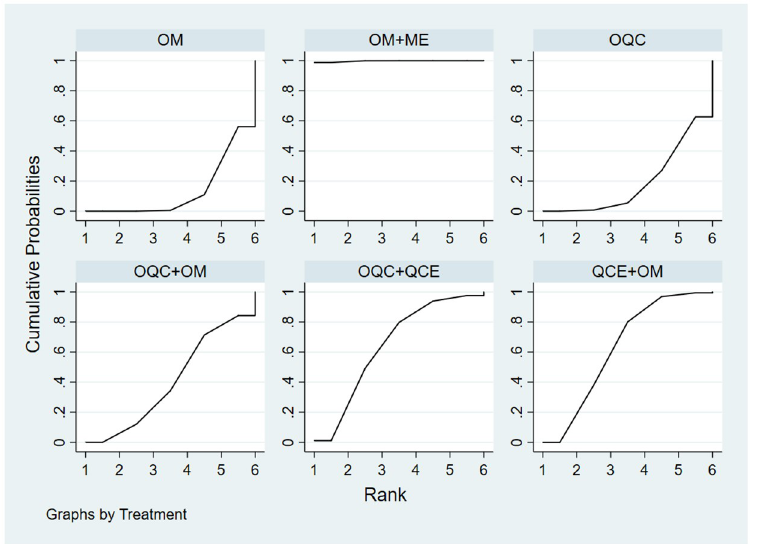
Fig 8. Surface under the cumulative raking curve of endoscopic